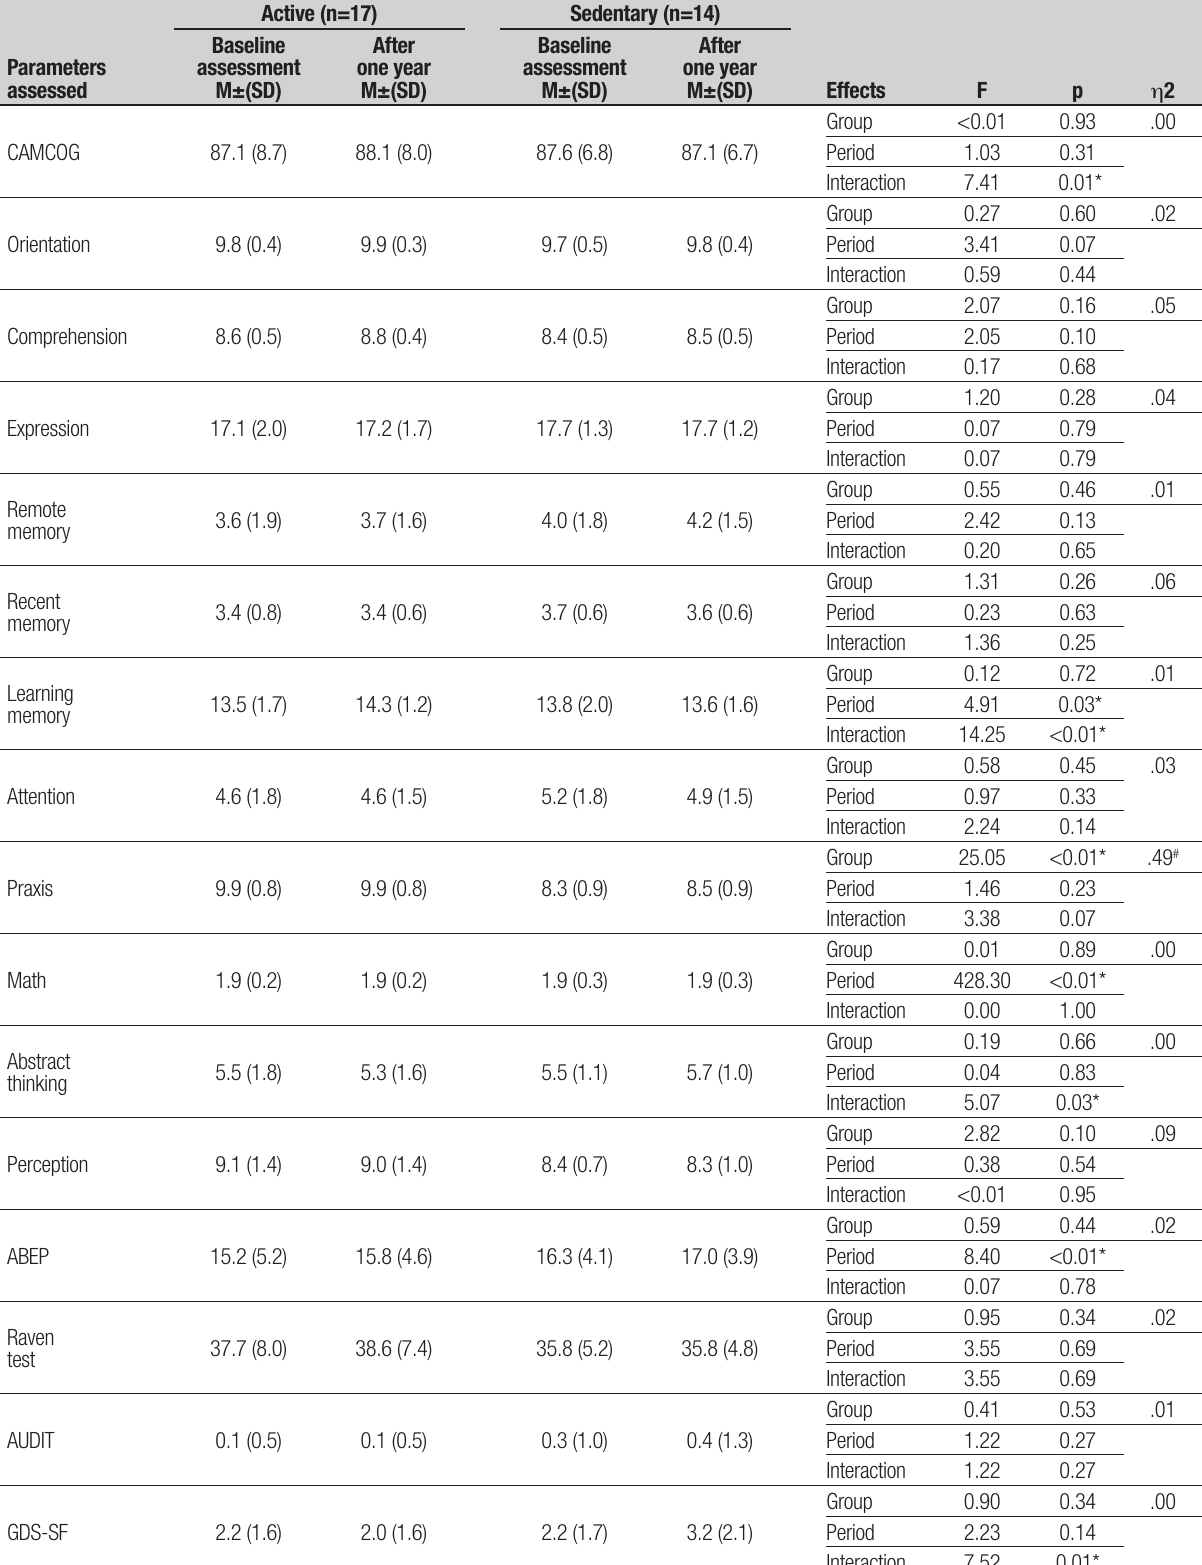
Table 1. Comparison between performances by groups on parameters assessed in the screening at baseline assessment and after one year.